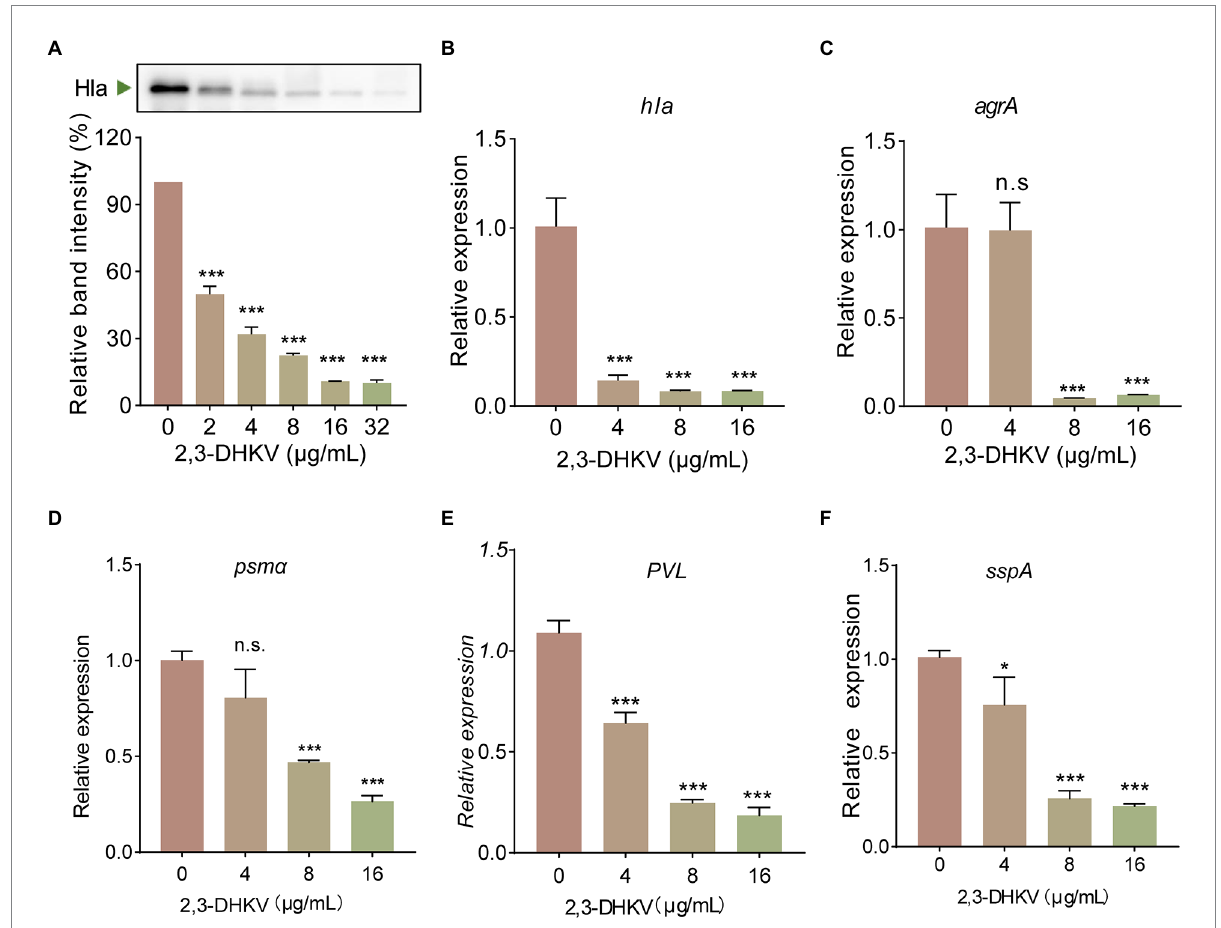
FIGURE 3 2,3-DHKV significantly decreases the expression of Hla and Agr system regulatory-related genes. (A) Expression levels of Hla in USA300 after treatment with different concentrations of 2,3-DHKV (0–32 μ g/ml) were determined by western blot. Transcription level of (B) hla , (C) agrA